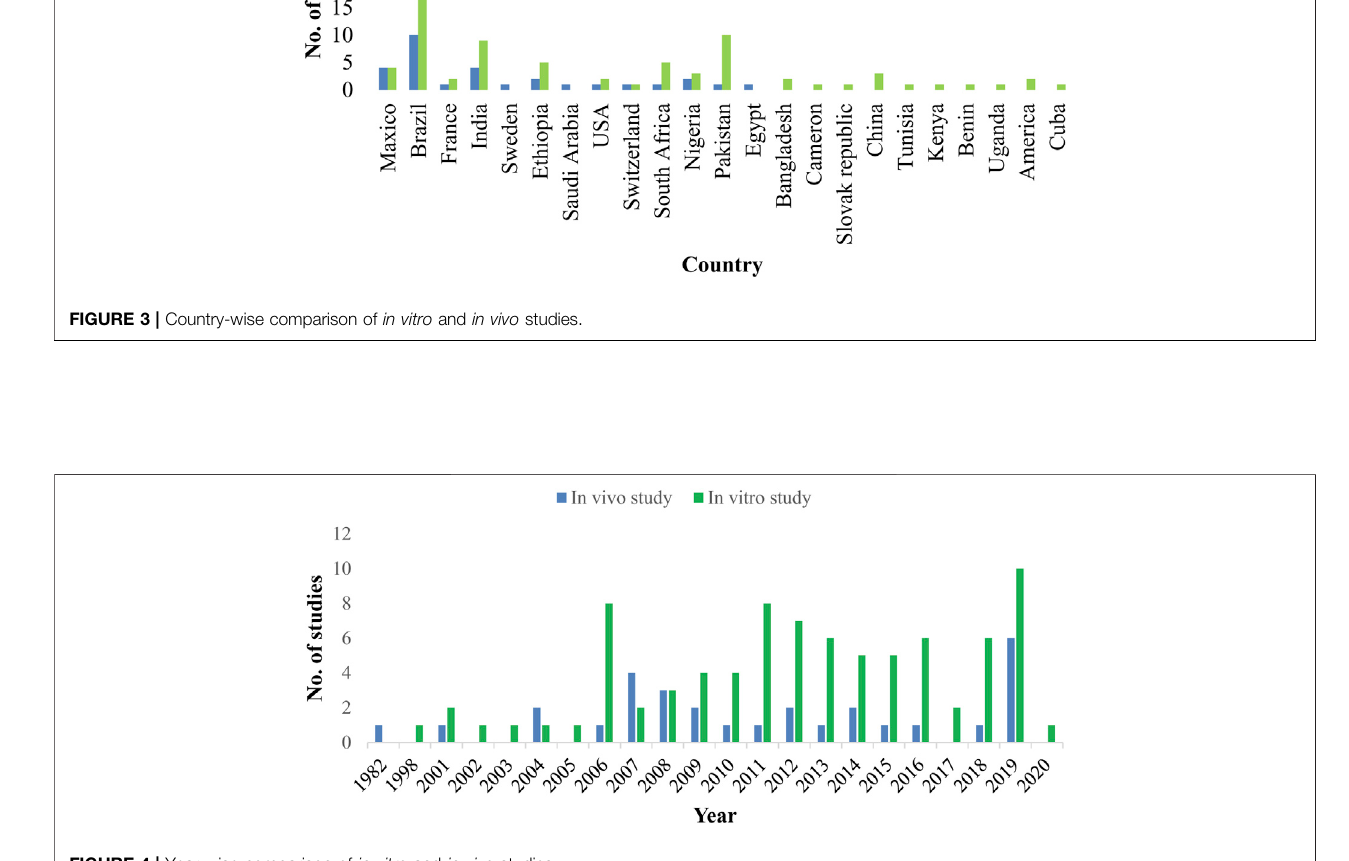
FIGURE 4 | Year-wise comparison of in vitro and in vivo